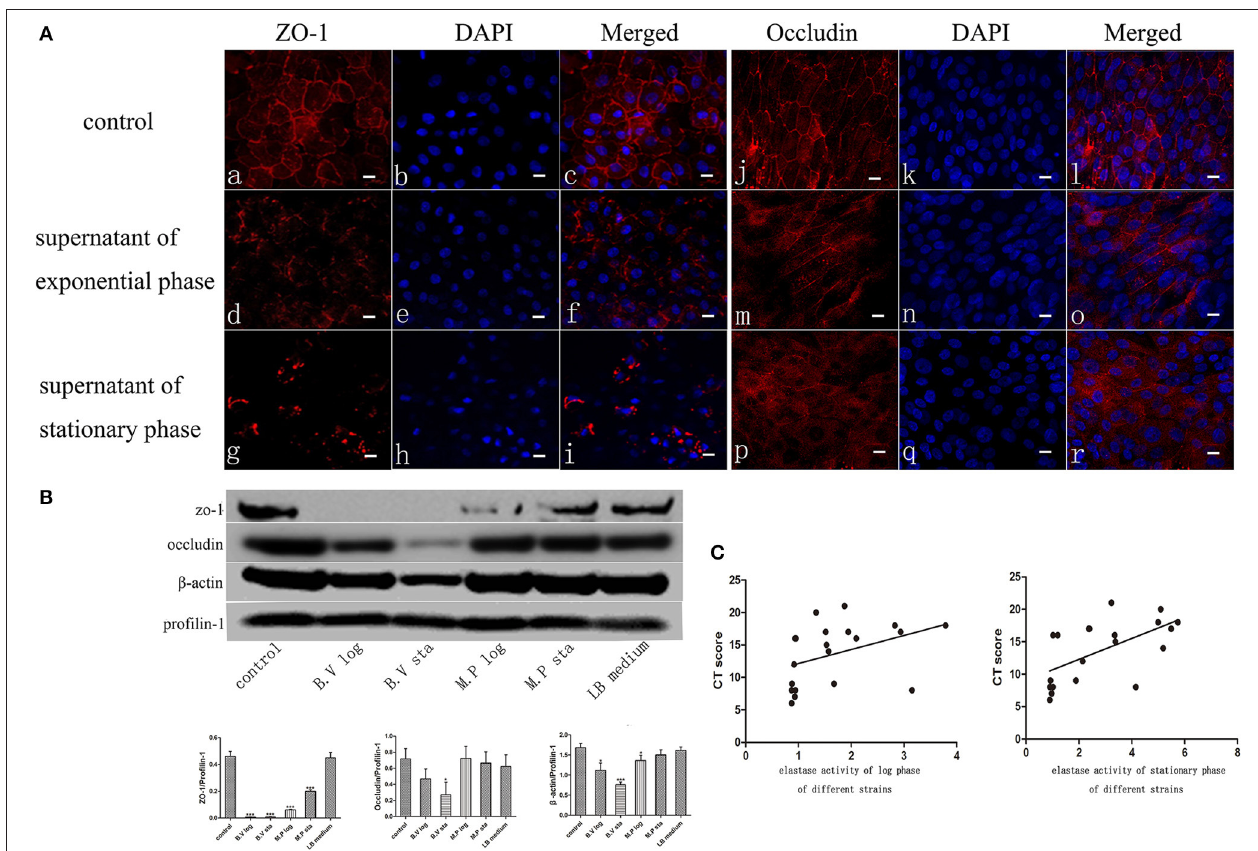
FIGURE 2 | P. aeruginosa exoproteins cause disruption of ZO-1, Occludin and Actin of primary human nasal epithelial cells (HNECs). (A) The effect of P. aeruginosa B.V strain exoproteins at Log phase (d-f and m-o) and Stationary phase (g-i and p-r) on the localization of Zona Occludens-1 (ZO-1) (red staining with DAPI stain in blue in a-i) and Occludin (red staining with DAPI stain in blue in j-r) using immunofluorescence confocal laser scanning microscopy 6h after application of the exoproteins. (B) Western blot analysis and relative densitometric quantification of Zona Occludens-1 (ZO-1), Occludin and β -actin after application of 5% (v/v) exoproteins of P. aeruginosa strains B.V and M.P for 24h. HNEC monolayers without treatment were control group. Luria-Bertani (LB) medium was used as the negative control. Profilin-1 was used as the loading control. Densitometric quantification relative to Profilin-1. (C) Spearman correlation analysis of Lund-Mackay Computed Tomography (CT) scores with elastase activity of 20 P. aeruginosa clinical isolates at log phase or stationary phase of growth. Results are representative of three independent experiments. * p < 0.05, *** p < 0.001. ANOVA, followed by Tukey HSD post-hoc